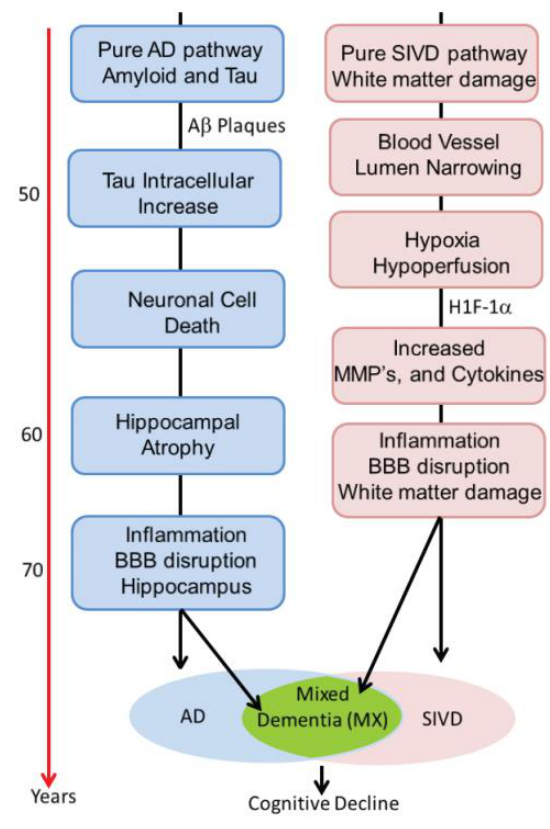
Figure 3. The concept of dual pathways leading to mixed dementia is shown schematically. On the left is the Alzheimer pathway. This begins early with deposition of amyloid and proceeds through stages of phosphorylated Tau, cell death, and atrophy. On the right the vascular pathway is shown, which also begins early with vascular risk factors that are poorly controlled. When the two pathways converge later in life, they form mixed dementia (MX). At this stage, there already is on-going inflammation from each pathway alone, which now is exaggerated. HIF-1 α is hypoxia inducible factor-1 α.